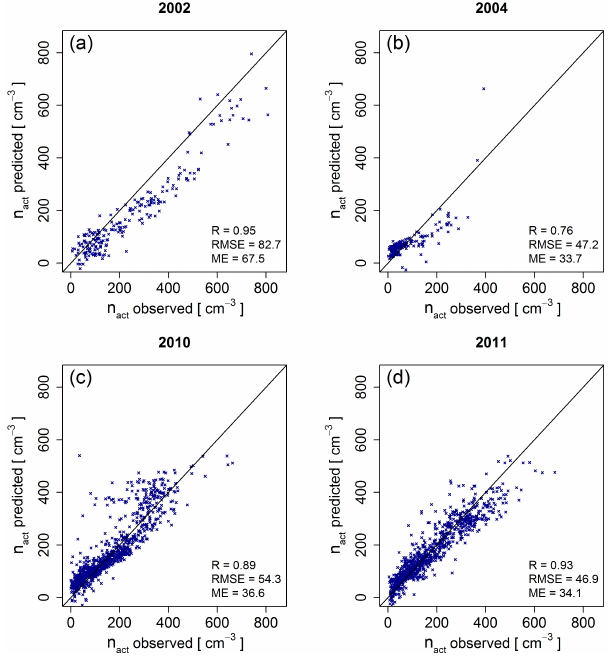
Figure 10. The modelled droplet numbers (Eq. 5) plotted against the observed number of residuals for each year separately.